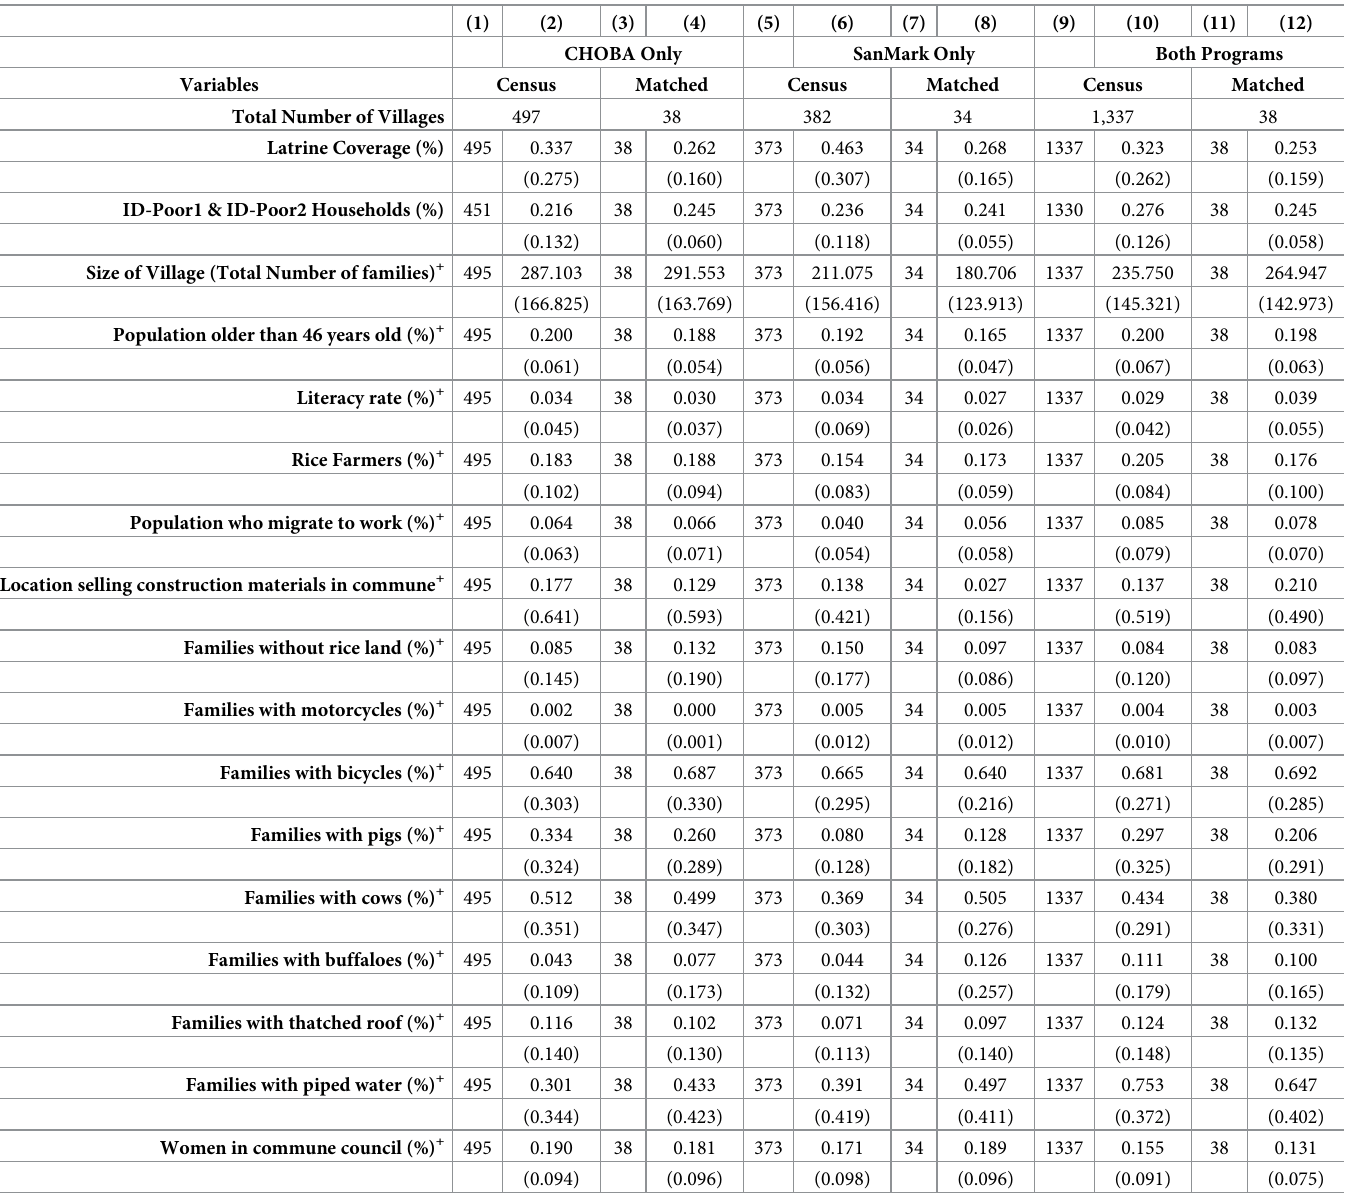
Table 1. Summary statistics of matched